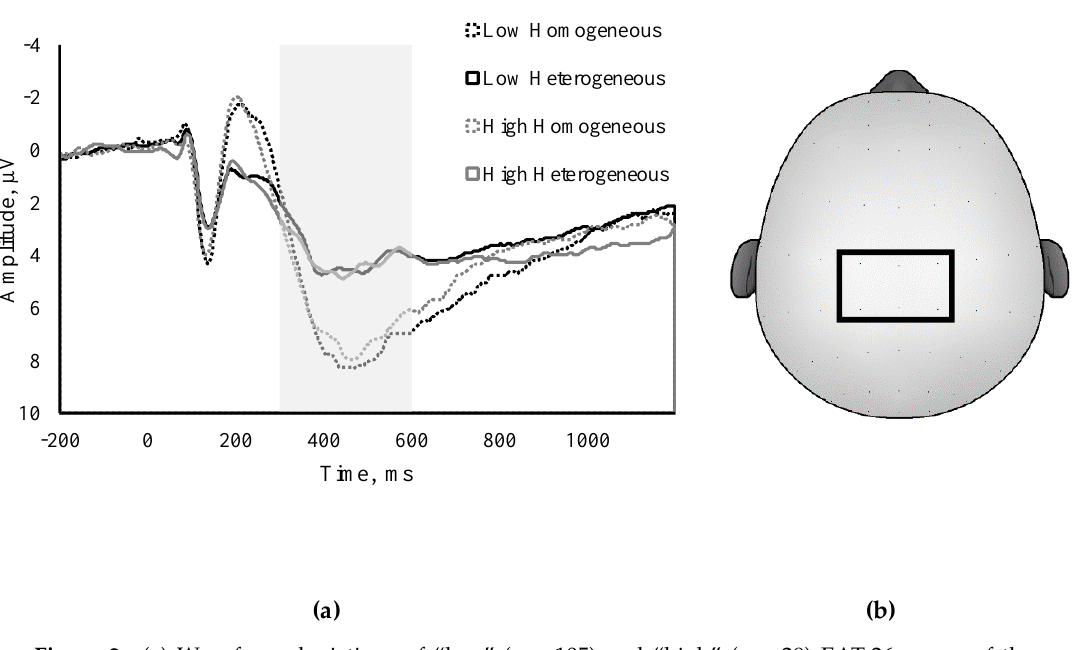
Figure 2. ( a ) Waveform depictions of “low” ( n = 105) and “high” ( n = 29) EAT-26 scores of the homogenous and heterogeneous Switch task trials, and ( b ) a topographic representation of the 6 electrode sites (C1, CZ, C2, CPZ, CP1, and CP2) used in the P3 region of interest